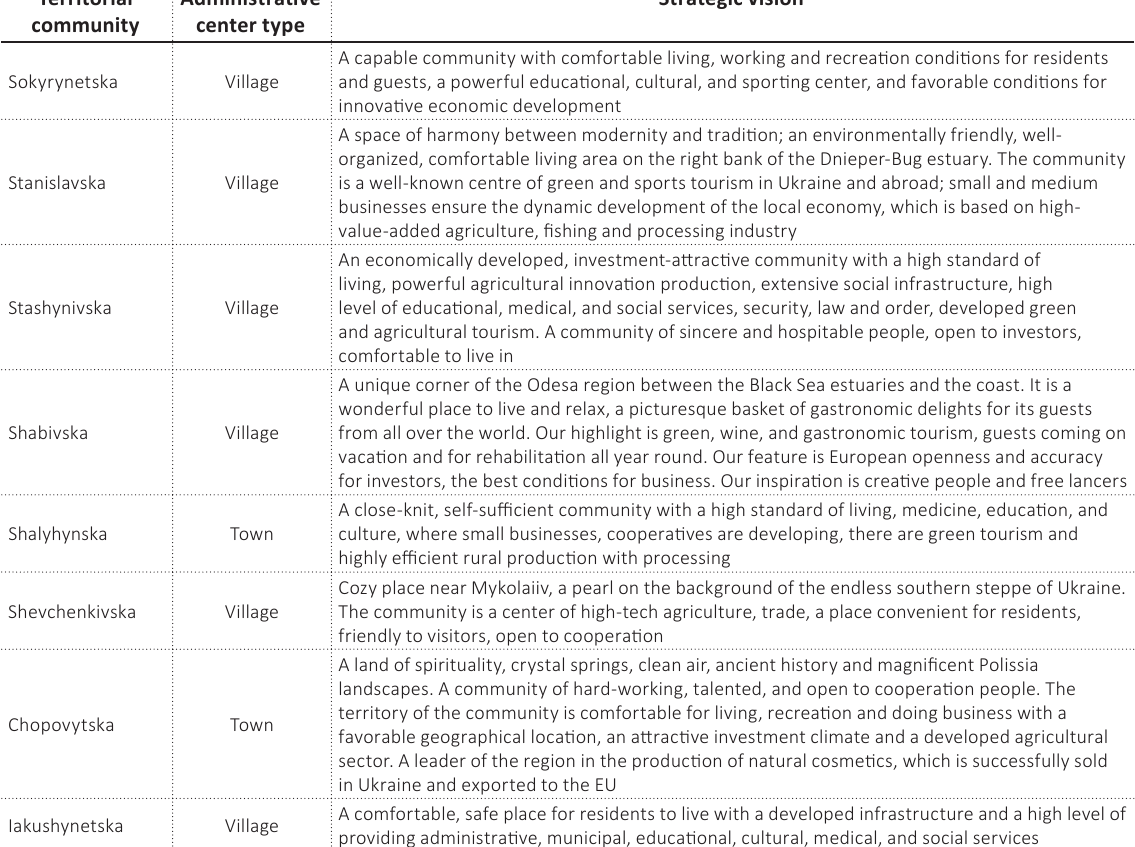
Table A1 (cont.). Strategic visions of the studied